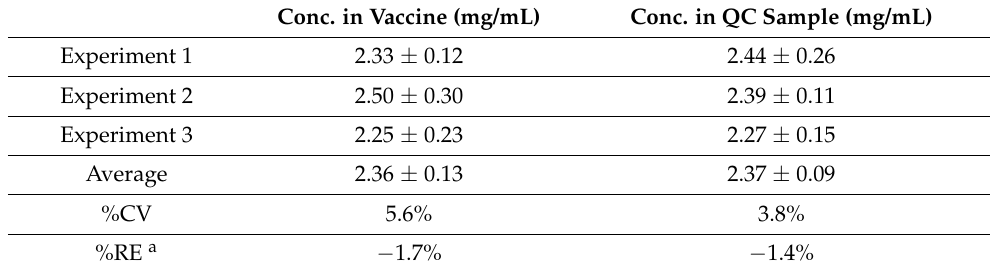
Table 3. Intermediate precision of TRIS concentrations for a vaccine preparation and the QC sample.